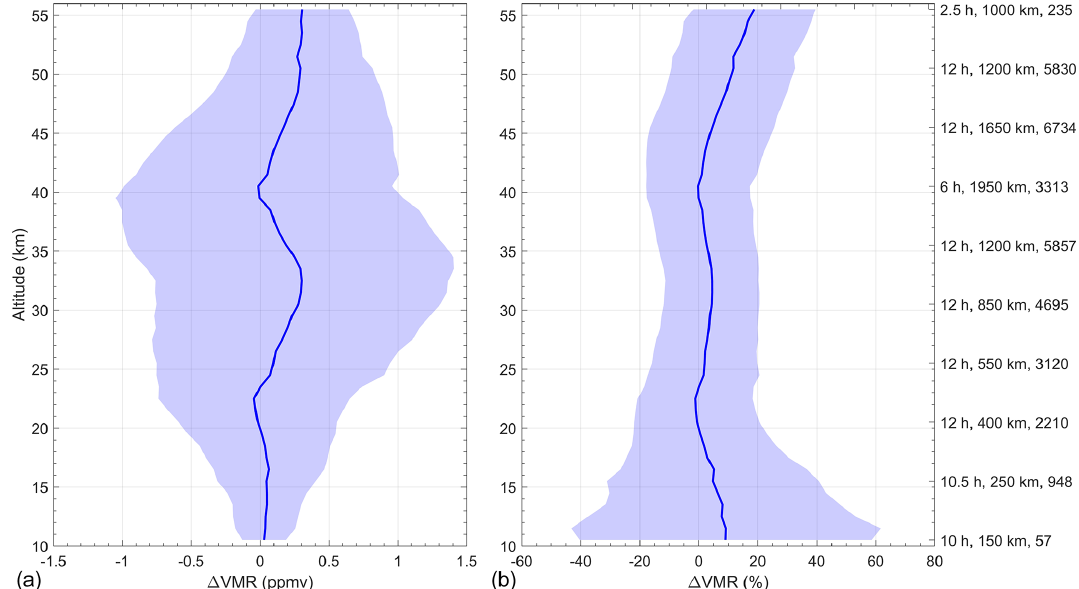
Figure 5. Comparisons between ACE-FTS and OSIRIS O 3 profile measurements at coincident criteria that, at each altitude, maximize the number of coincident profiles while keeping estimated geophysical variability below 10%. Solid lines indicate the mean of the differences ( a : absolute values; b : relative differences), and shaded regions are the corresponding 2 σ variations from the